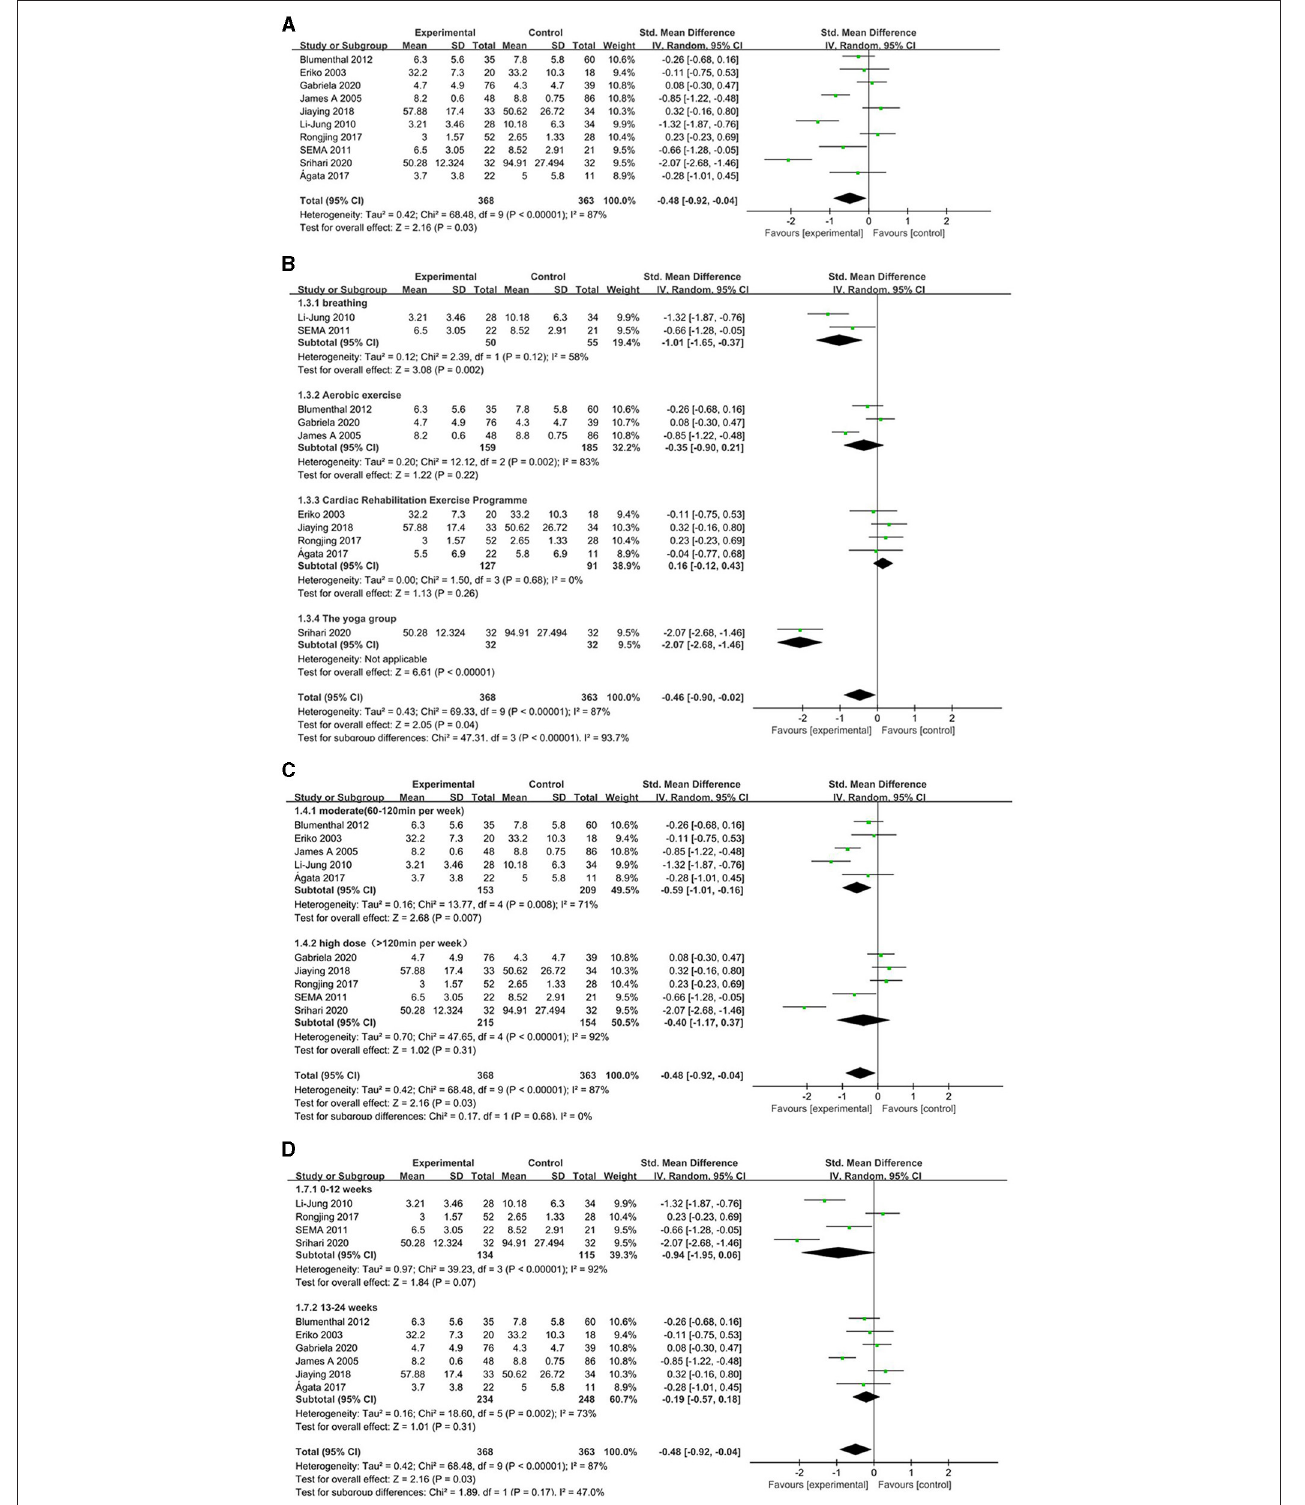
FIGURE 5 | Comparison of acupuncture related therapies in terms of UPDRS-II. (A) The effect of exercise therapy on depression in patients with coronary heart disease. (B) The effect of different exercise types on depression in patients with coronary heart disease. (C) The effect of different exercise time on depression in patients with coronary heart disease. (D) According to the length of intervention, exercise therapy the impact of depression in patients with coronary heart disease.